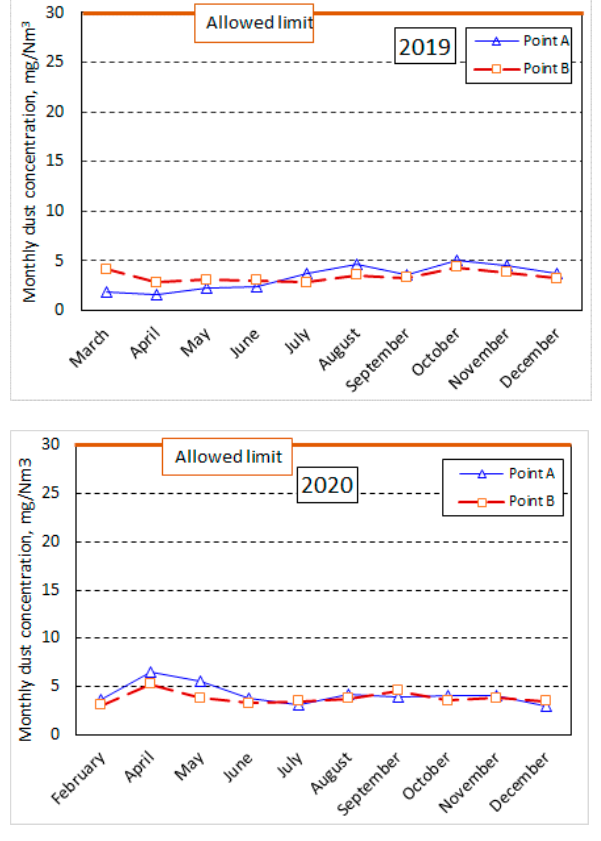
Figure 4. Distribution of dust emissions at bag filters in the cement mill section no.1 (mill filter—point A and separator filter—point B, Figure 1) of the analyzed cement plant.